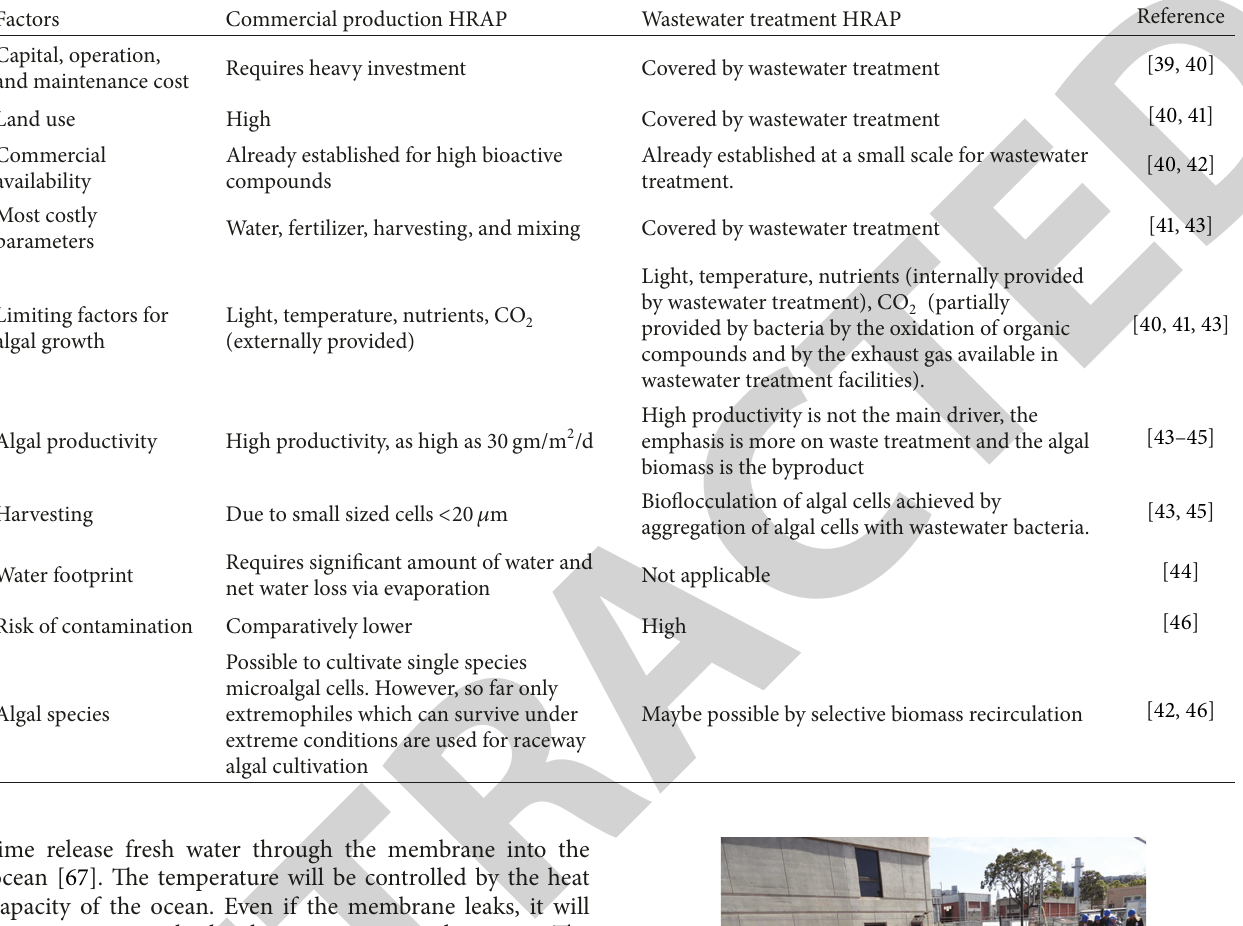
Table 2: Comparison of commercial and wastewater treatment HRAP.